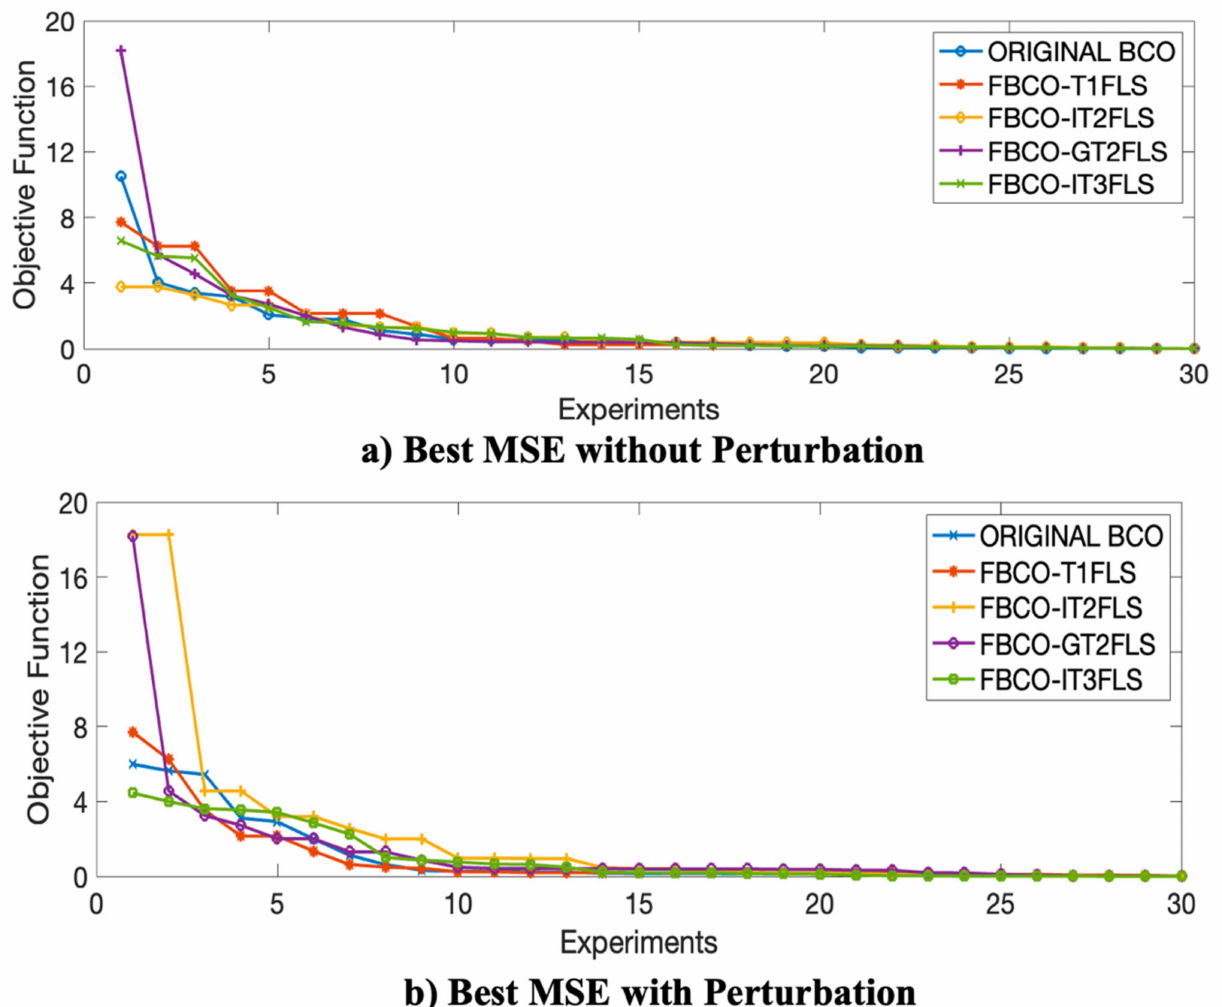
Figure 25. Comparative of the Best convergence for each Fuzzy Sets and original BCO algorithm, ( a ) without Perturbation and ( b ) with